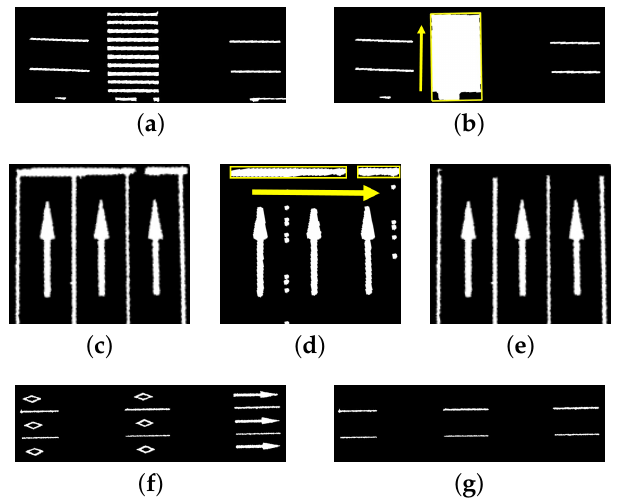
Figure 11. ( a ) A binary image with a zebra crossing. ( b ) After a closing operation, the zebra crossing is connected to a rectangle whose long axis is nearly perpendicular to the trajectory. ( c ) A binary image with a stop line. ( d ) After an opening operation, the stop line is separated into several rectangles whose long axes are nearly perpendicular to the trajectory. ( e ) The stop line is removed. ( f ) A binary image with straight-ahead arrows and diamond markings. ( g ) The false positive markings are removed through shape